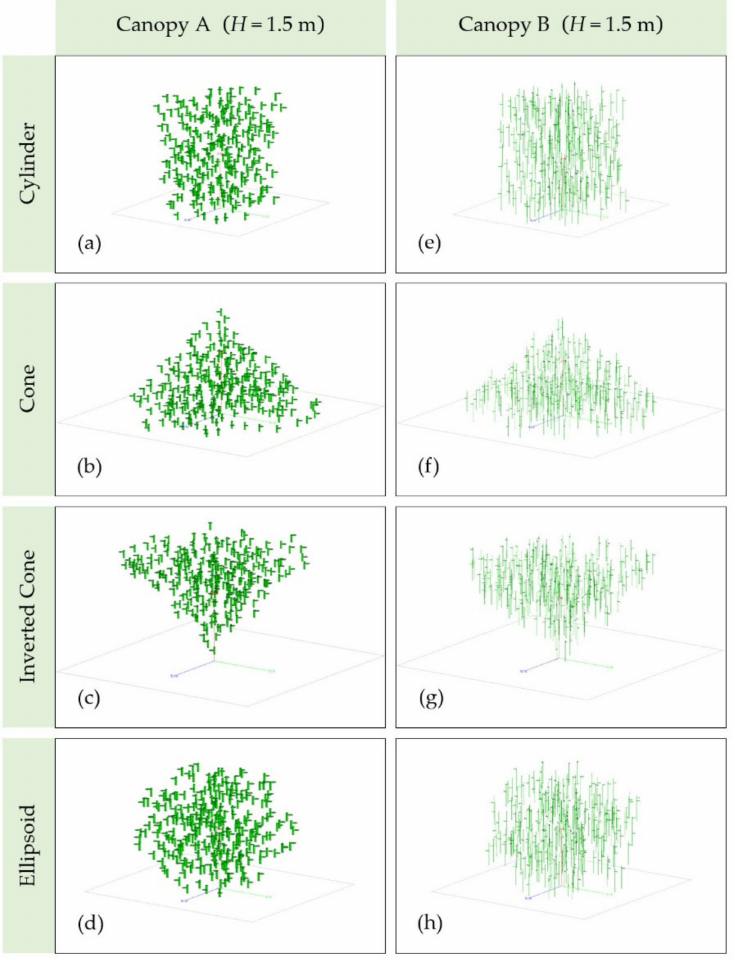
Figure 6. The four 3D geometrical vegetation canopies with different crown shapes when H = 1.5 m. In ( a – d ), the parameters from Table 1 were used as model inputs; in ( e – h ), the parameters from Table 2 were used as model